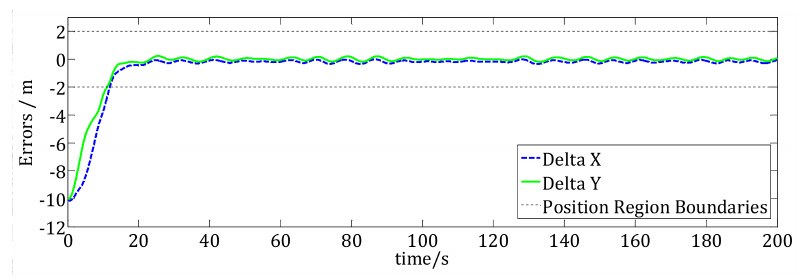
Figure 17. Position errors of the USV under the NTTC